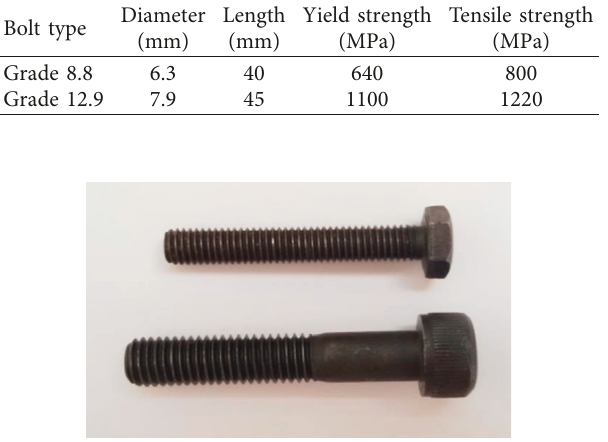
Figure 4: Typical